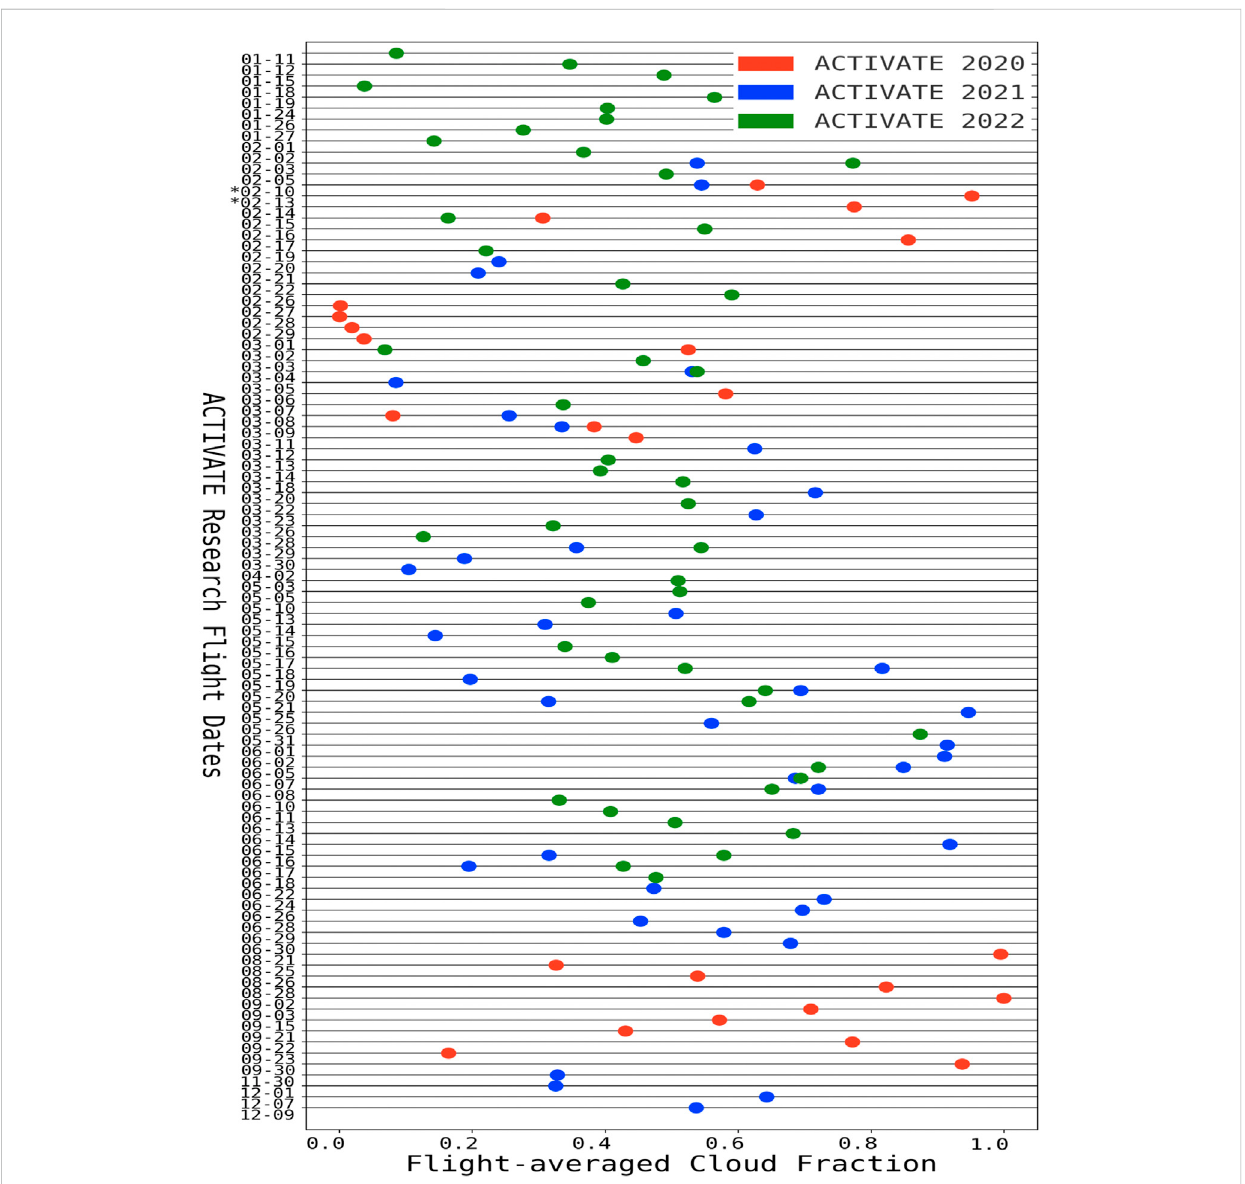
ACTIVATE CDNN fl ight-averaged cloud fraction. In the aforementioned fi gure, we show the fl ight-averaged cloud fraction results for 2020, 2021, and 2022 ACTIVATE fl ight campaigns. Data points are generated by using the forward CDNN to generate cloud masks for each available research fl